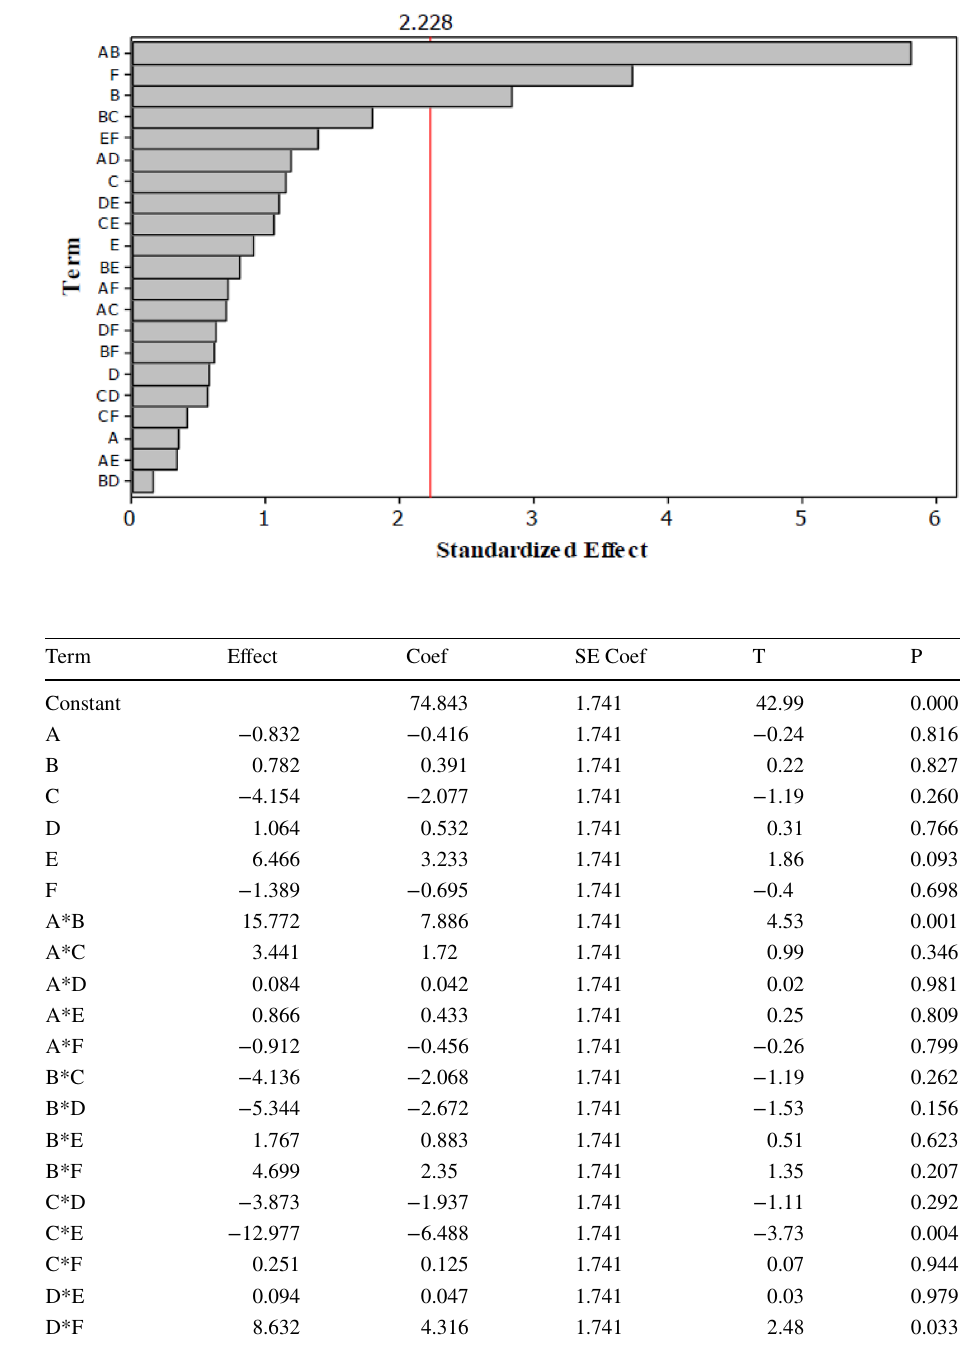
Fig. 7 Pareto chart for % E Cd(II)